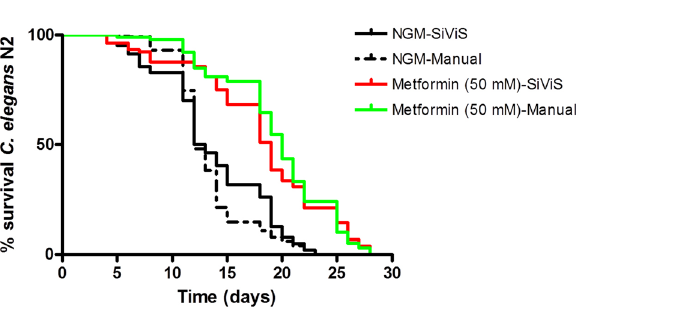
Figure 7. Manual and post-process lifespan comparison of daf-2 mutant strain. The graph was obtained with GraphPad Prism v. 4. ( a ) Curves obtained in SIVIS differed significantly using the standard correction algorithms with the threshold (th) set in 14 ( th = 14 ). ( b ) Post process of correction algorithms set in th = 38 enabled correct survival measurement of lifespan in long-lived strains like CB1370 ( daf-2 ). Data from two independent assays ( n = 100 and 8 plates/condition).